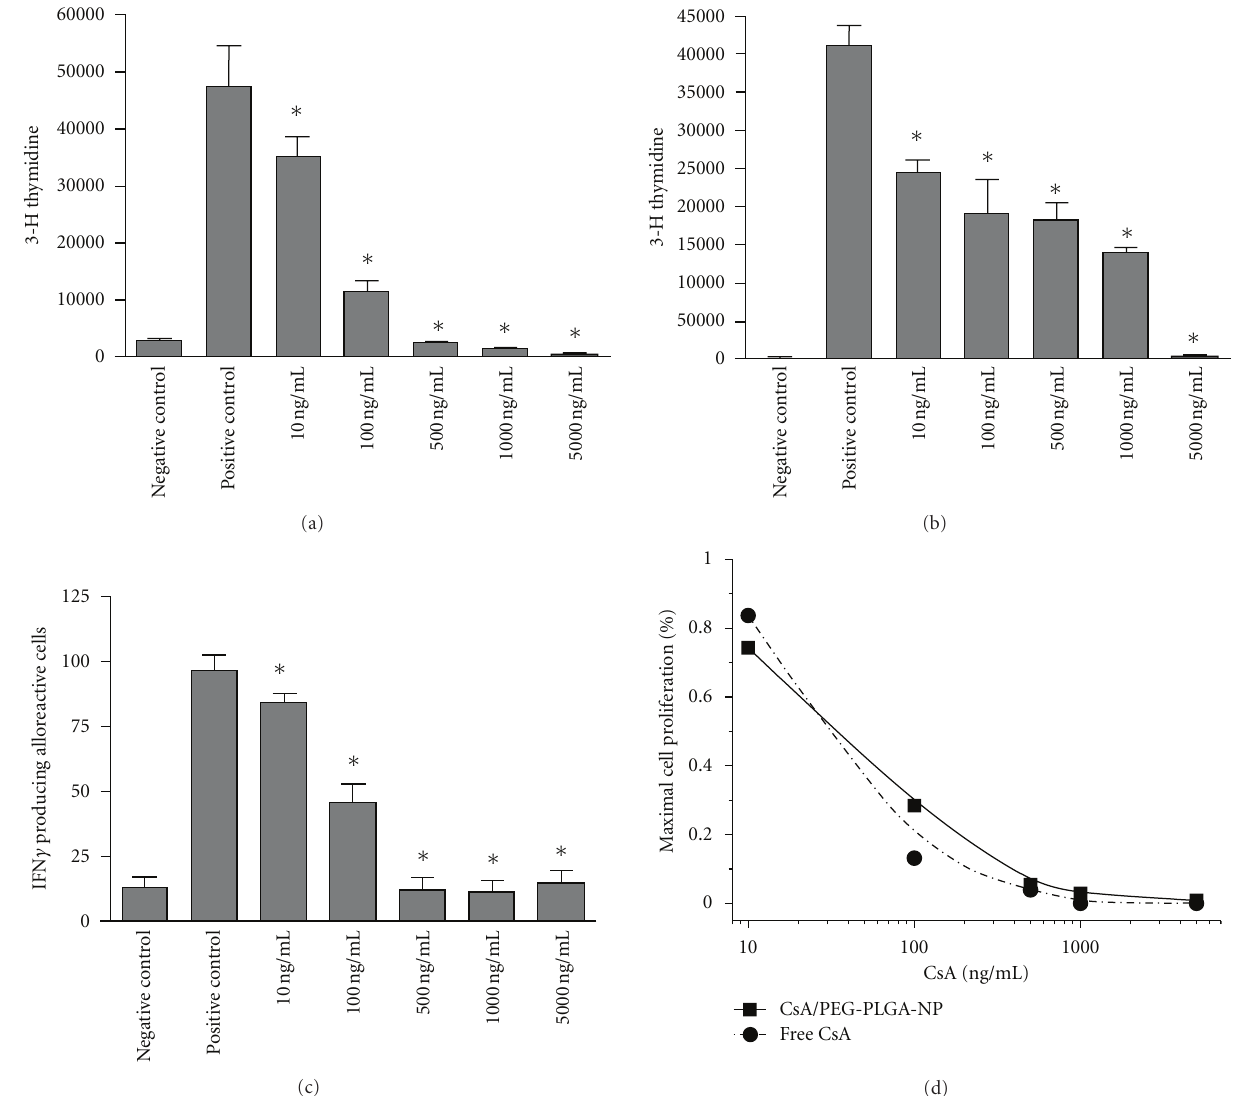
Figure 4: The CsA/PEG-PLGA-NPs suppress T-cell activation in MLR, CD3-CD28, and ELISpot assays. (a) CsA/PEG-PLGA-NPs showed dose-dependent inhibition of T-cell proliferation in an MLR assay starting at 10ng/mL equivalent concentration of CsA. (b) CsA/PEG- PLGA-NPs suppressed T-cell proliferation in a CD3-CD28 stimulation assay in a dose-dependent manner starting at 10 ng/mL. PEG-PLGA- NPs was unable to suppress. Data are expressed as the mean cpm of the [H] thymidine uptake by triplicate cultures and represented by the y axis. The di ff erent concentrations used are represented by the x axis ( ∗ P < 0 . 05). Data are representative of two separate experiments. (c) The incidence of cells producing IFN- γ was first measured by ELISpot assay from cultured splenocytes of C57Bl/6 animals responding to BALB/c stimulating splenocytes in vitro . As compared to the positive control (untreated stimulated cells), CsA-NPs reduced the frequency of IFN- γ -producing cells in a concentration-dependent manner ( ∗ P < 0 . 05). Data are representative of two separate experiments ( ∗ P < 0 . 05). (d) IC 50 calculation using the percentage of cell proliferation in a MLR assay, measured by thymidine uptake in response to increasing dose of free CsA and CsA equivalent of CsA/PEG-PLGA-NPs ( ∗ P < 0 .